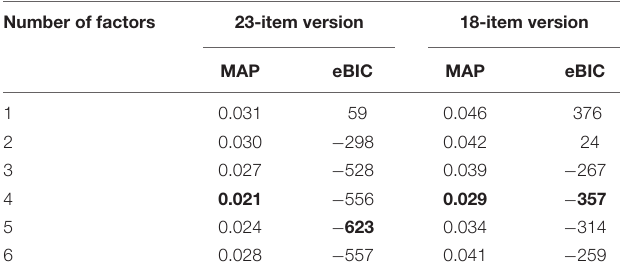
TABLE 3 | Statistics summary and the mean of the correlation of within-subscale and between-subscale of implicit theories measures. Number of factors 23-item